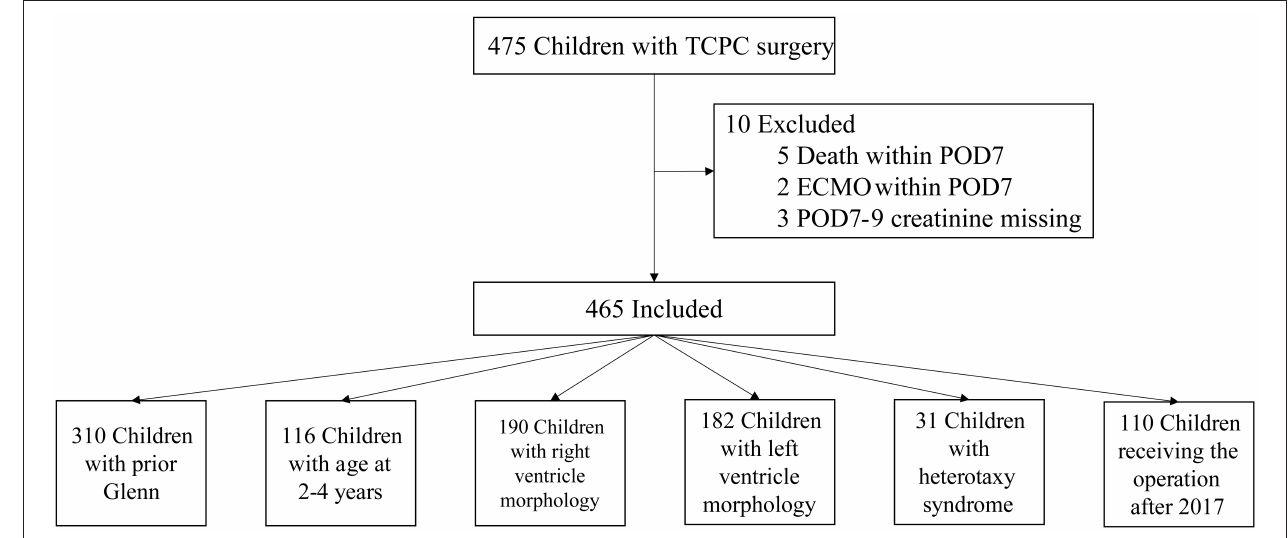
FIGURE 1 | The flowchart of inclusion and exclusion criteria and the details of six